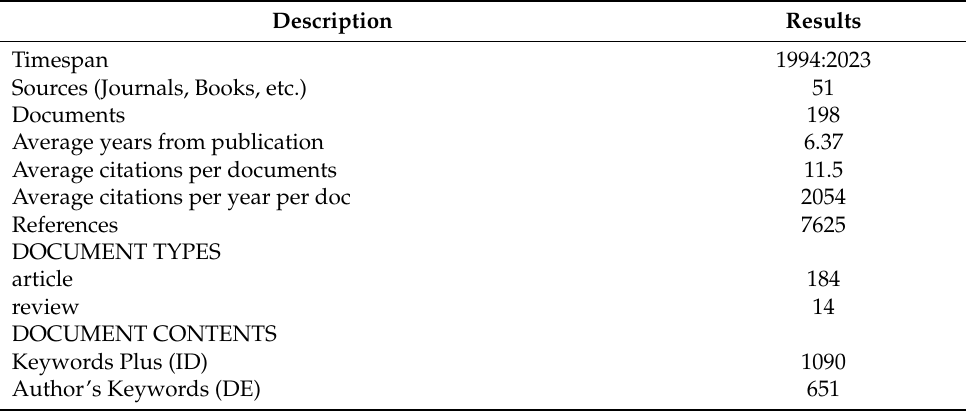
Table 1. Dataset descriptive